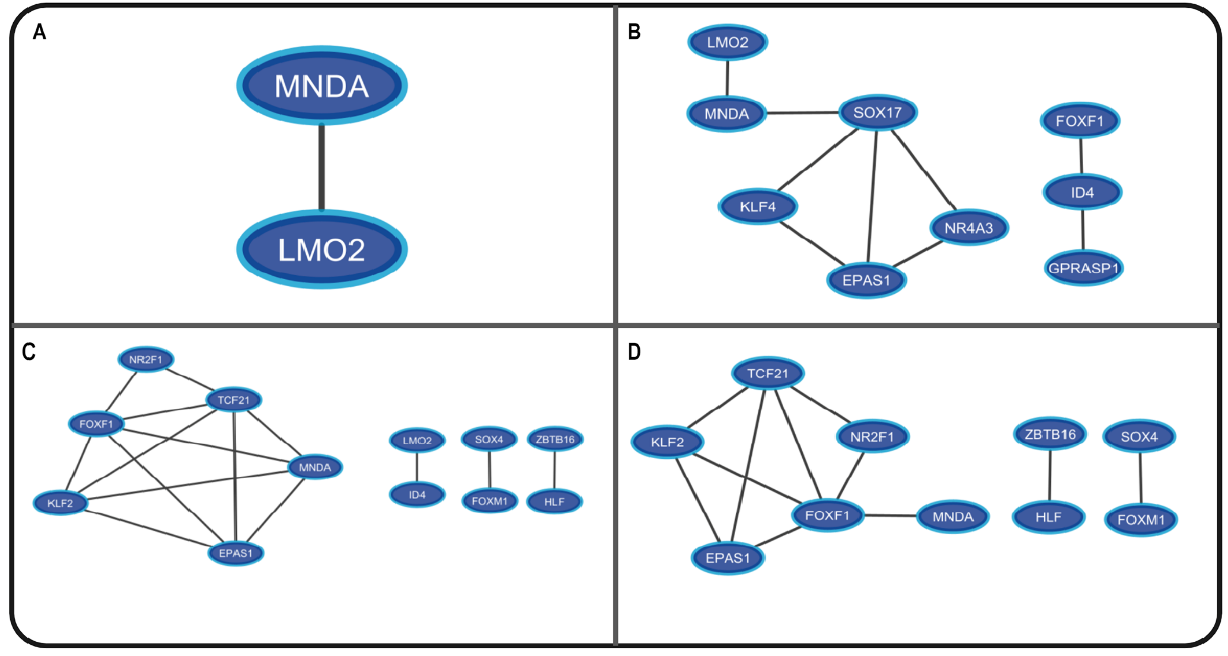
Figure 6. Coregulatory networks formed by the most frequently dysregulated transcription factors related to the control of gene expression of ( A ). NSCLC and PAH deregulated genes, ( B ). NSCLC deregulated genes, ( C ). SCLC and PAH deregulated genes, and ( D ). SCLC deregulated genes.